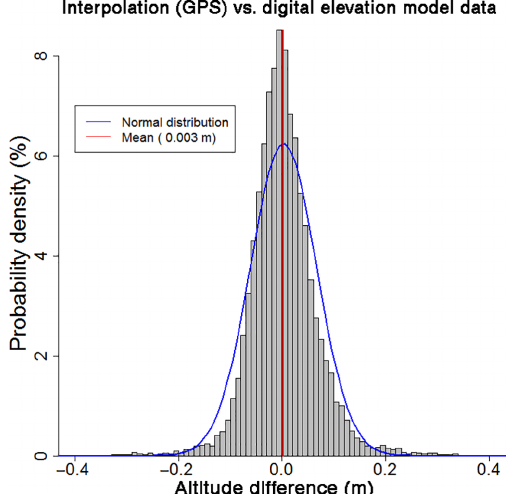
Figure B2. Probability density of the elevation differences be- tween the interpolated bare ground surface and the Digital Elevation Model ground surface.